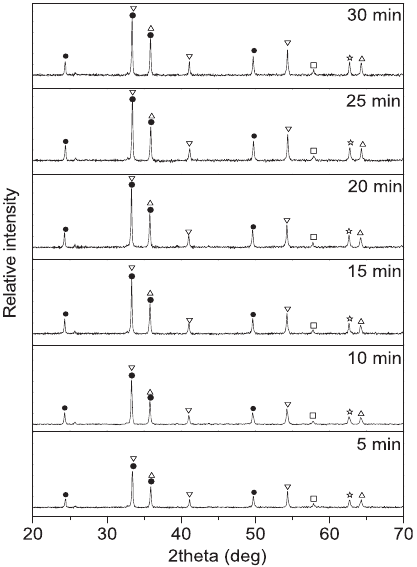
Figure 11: XRD patterns of HCVTM pellet roasted at 1,573 K at different roasting